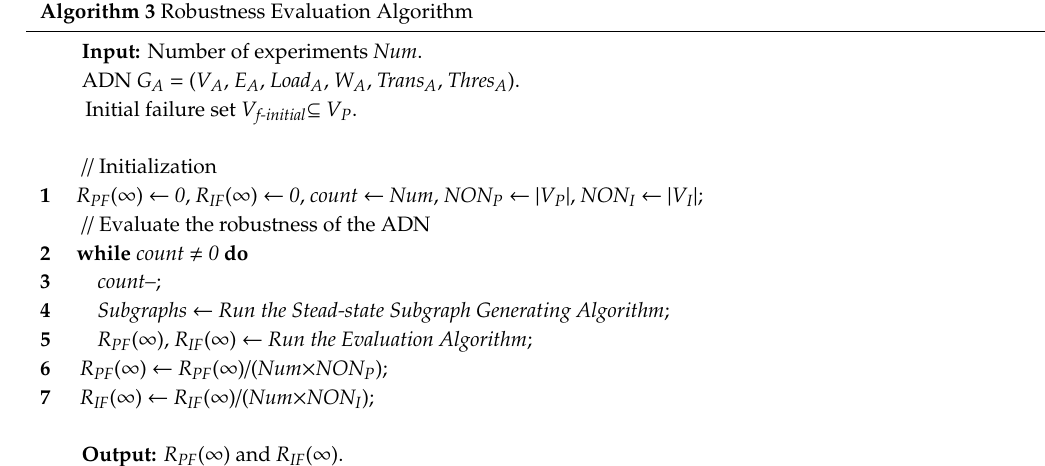
Algorithm 3 Robustness Evaluation